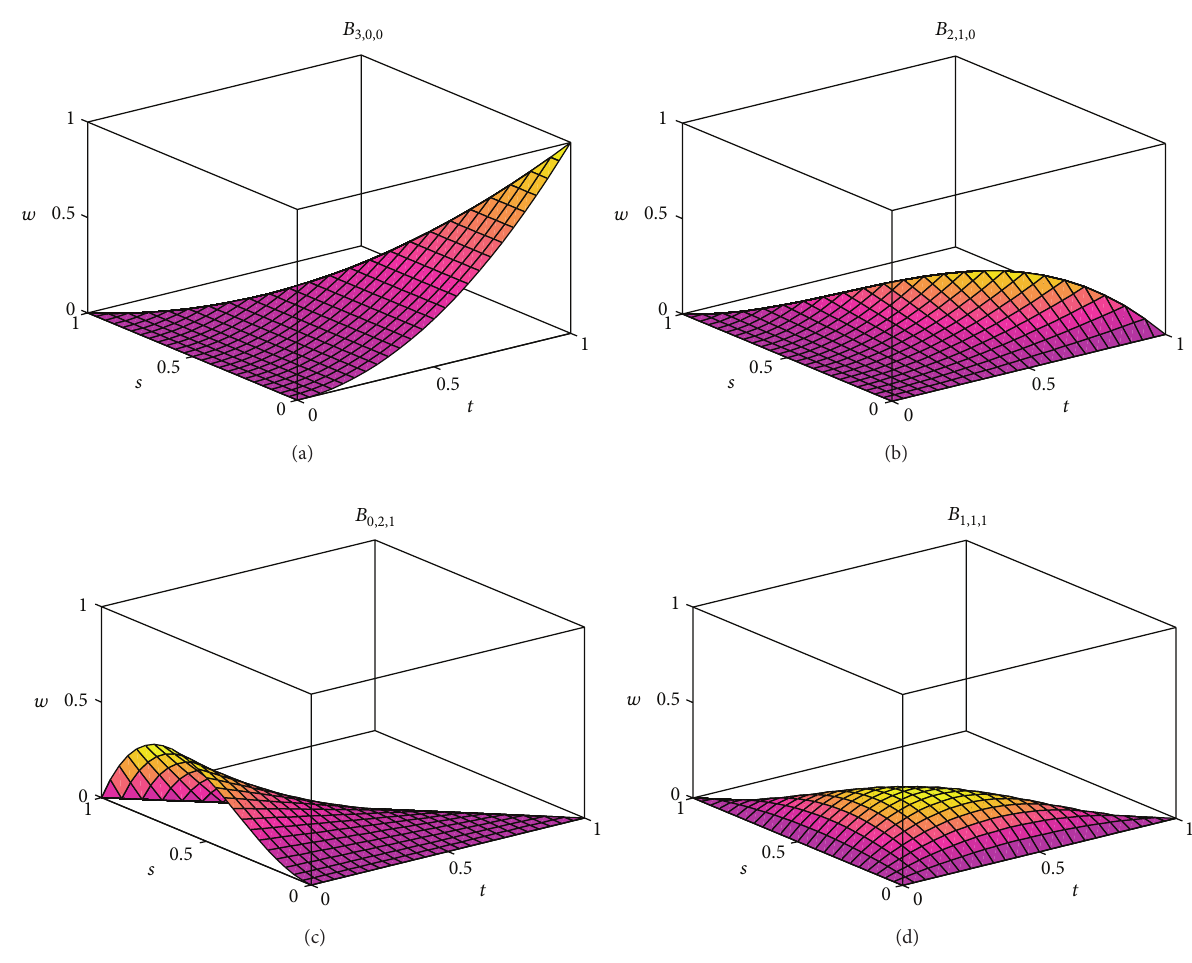
Figure 10: Some plots of quartic rational Said-Ball-like basis functions over a triangular